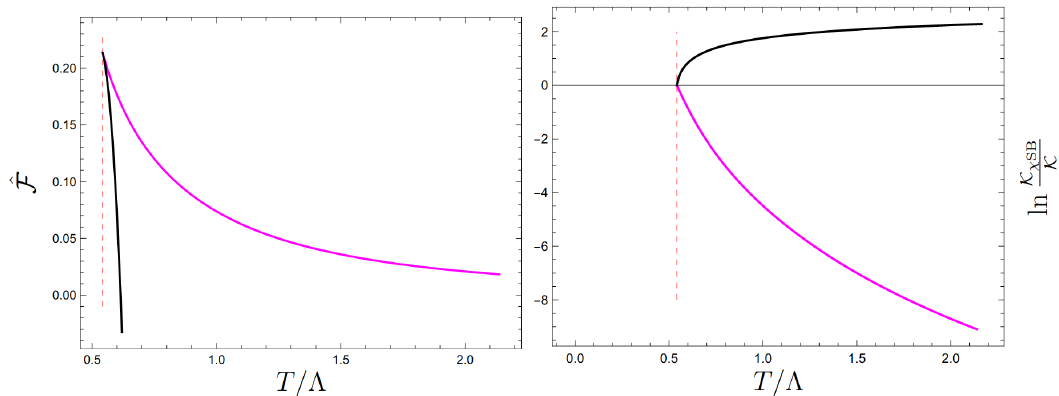
ˆ Figure 1 . The left panel: the reduced free energy density F (2.7) of the deconfined chirally symmetric phase (the black curve), and the deconfined (ordered) phase with spontaneously broken chiral symmetry (the magenta curve) of the cascading gauge theory plasma. The vertical dashed red lines indicate T (2.8). The ordered phase is exotic: it extends for T > T . The right χ SB χ SB panel: the Kretschmann scalar K for the corresponding phases computed for the dual black branes at the horizon. We use K = K ( T = T ) χ SB χ SB